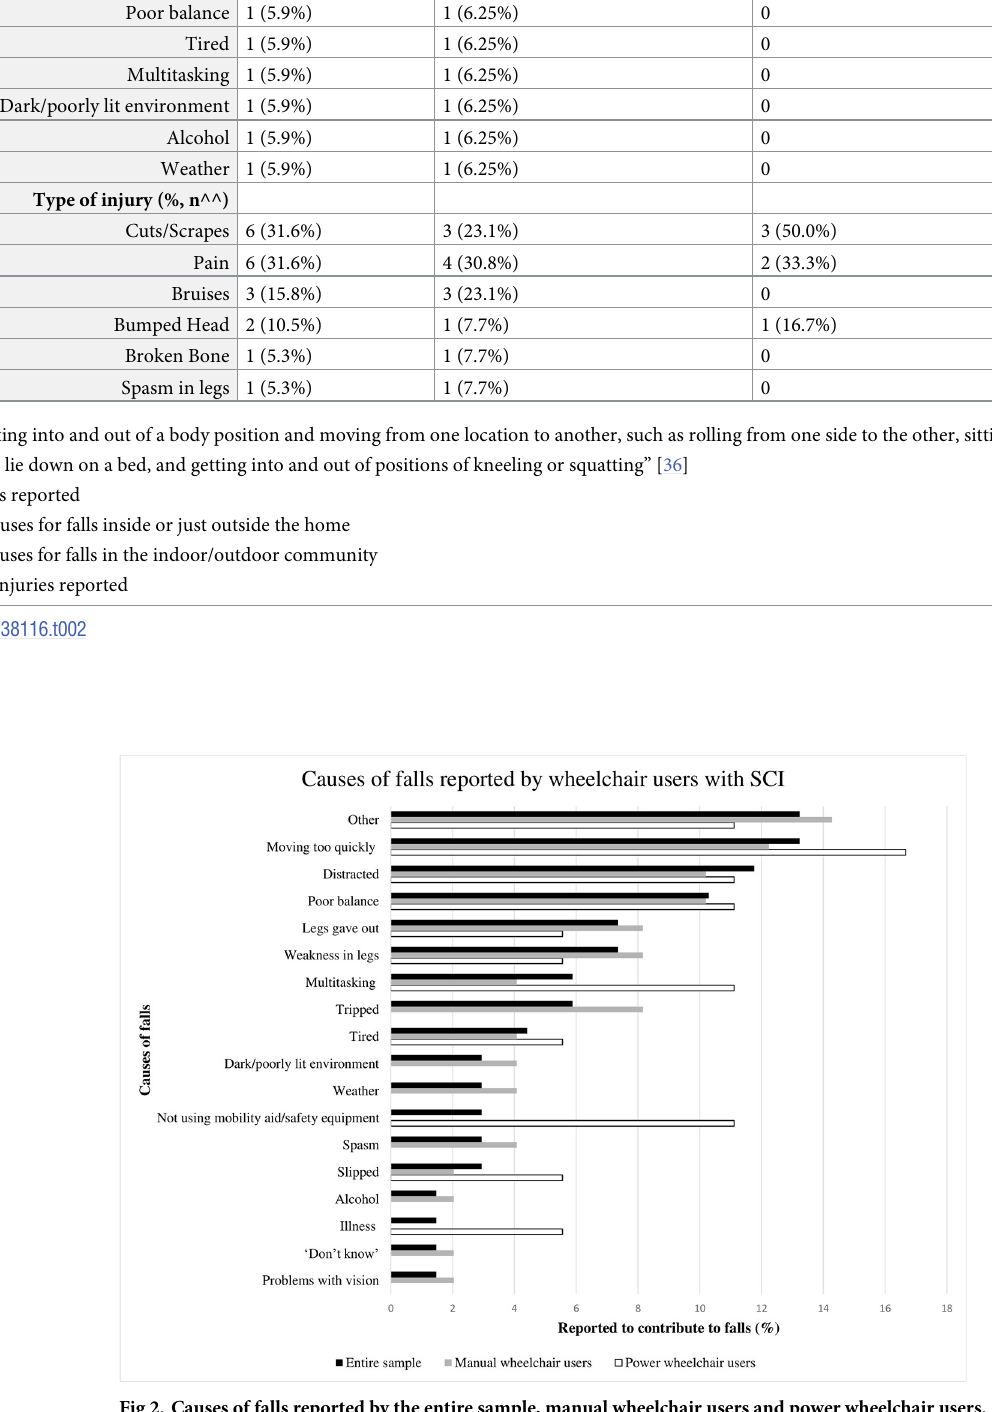
Fig 2. Causes of falls reported by the entire sample, manual wheelchair users and power wheelchair